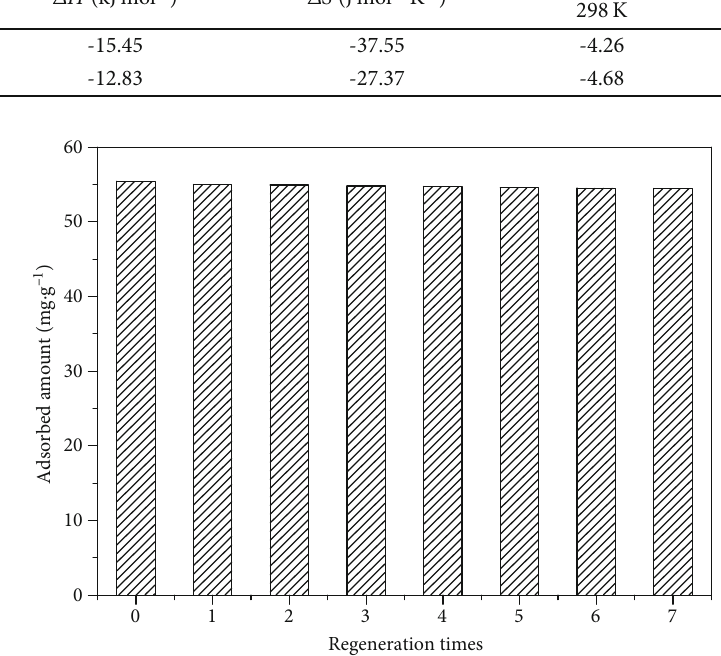
Table 6: Thermodynamic parameters of MB adsorption on construction waste and chabazite. Sample